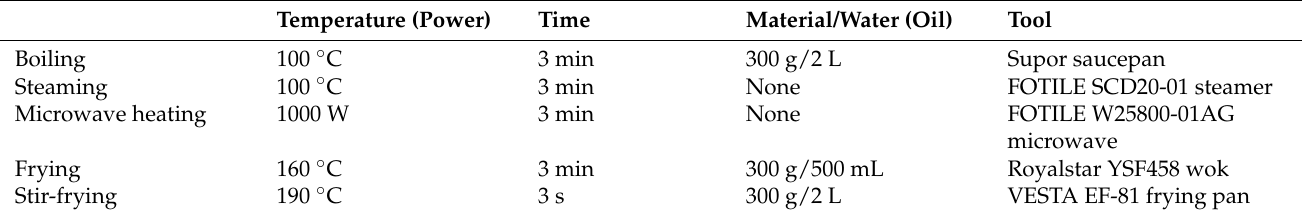
Table 5. Cooking conditions of different cooking